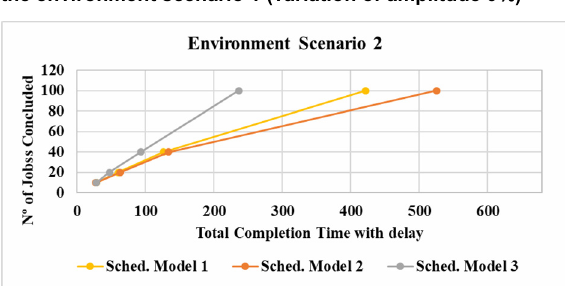
Figure 5. Simulation results of 3 Scheduling Models over the environment scenarios (variation of amplitude 50%)